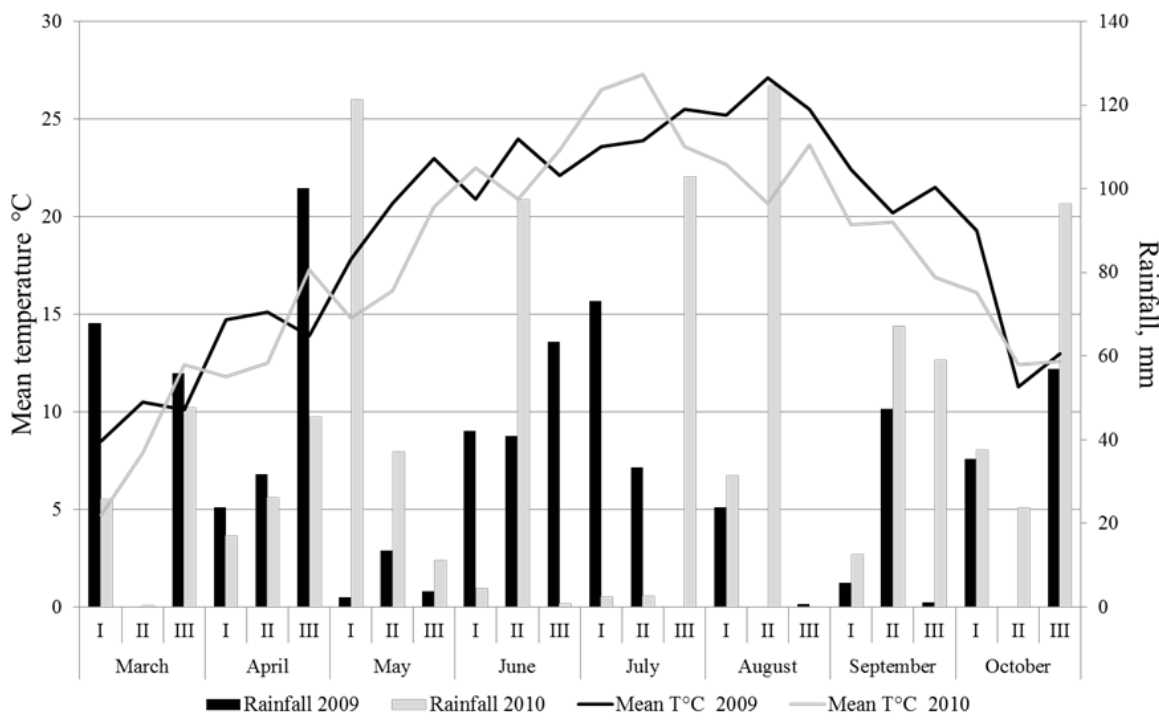
Figure 1. Environmental data (mean temperature, rainfall) recorded at CRA-MAC in 2009 and